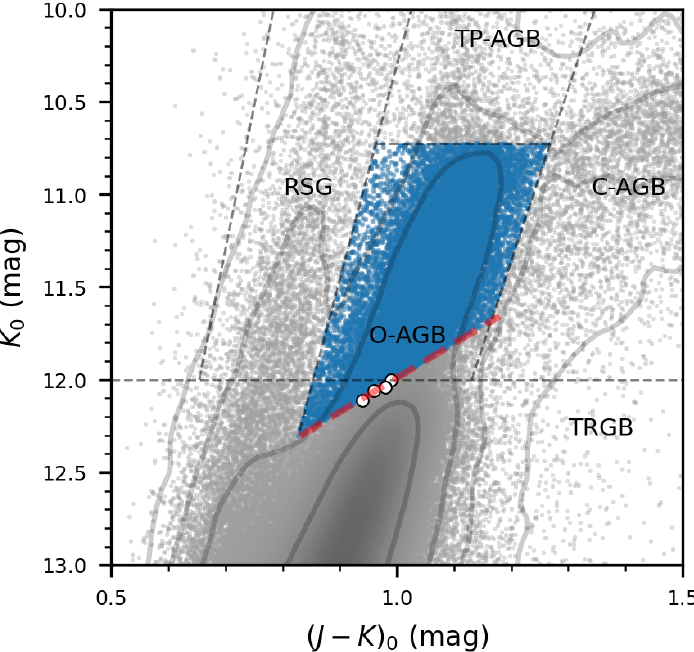
Figure 7. Comparison of the results of the LMC taking sloped TRGB and horizontal TRGB. The red line represents the sloped TRGB, and the white dots represent the saddle points we detected in different bins by the ridge method of number density analysis. The O-AGBs suggested by the sloped TRGB are represented by blue